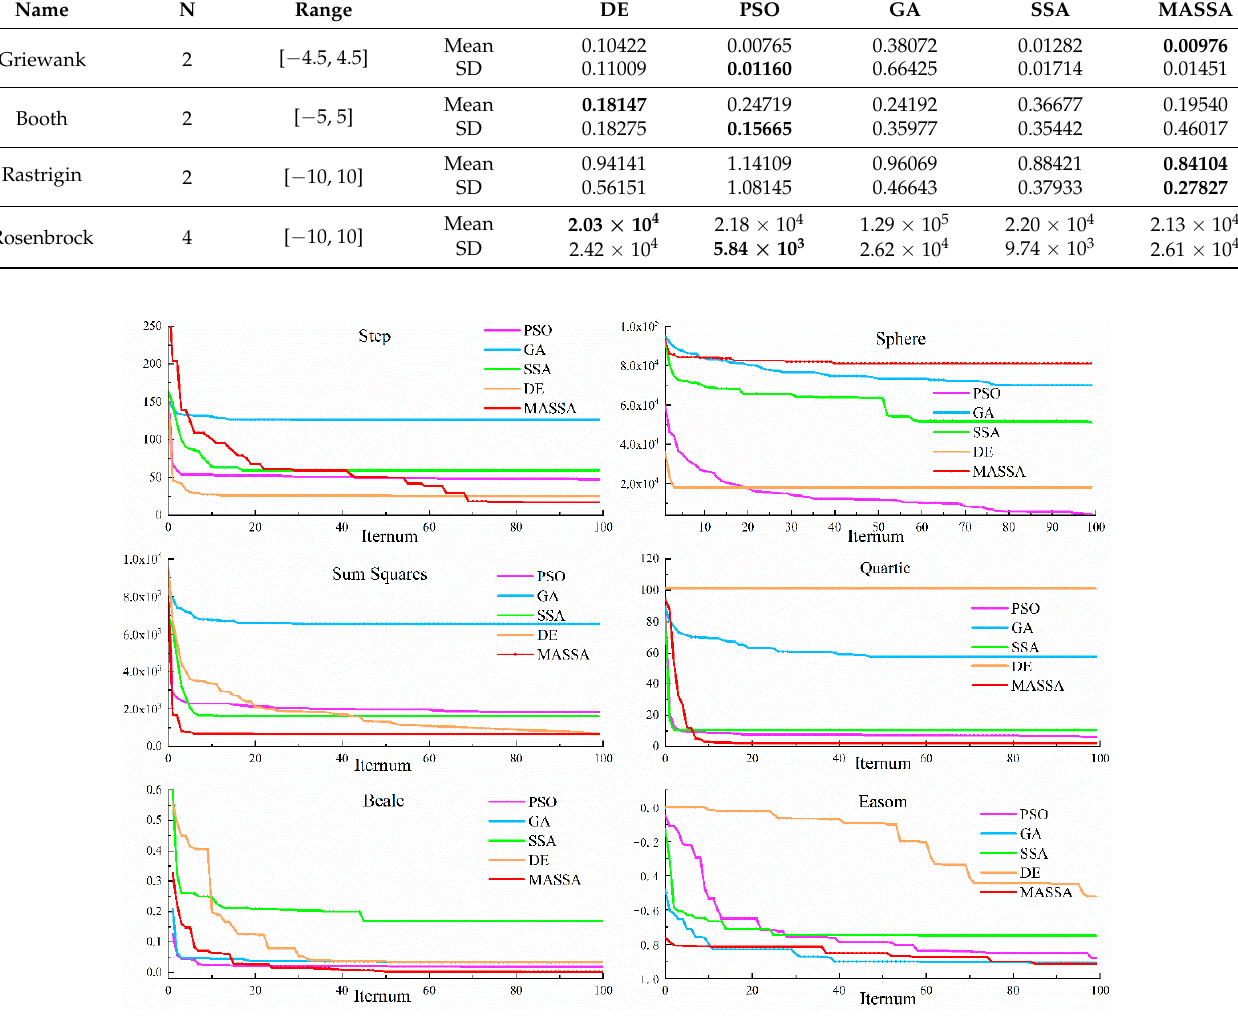
Figure 3. Convergence results 1 of unimodal benchmark functions.